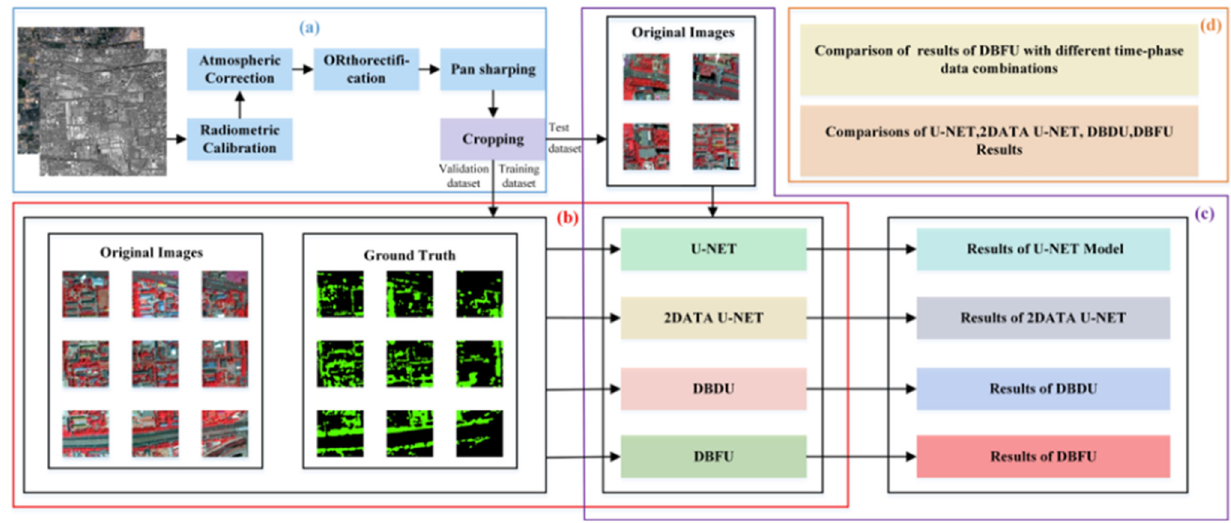
Figure 1. All processing procedures in this paper: ( a ) satellite image preprocessing; ( b ) model training; ( c ) model prediction; ( d ) comparison of results from all methods and effects of various time-phase satellite image combinations.